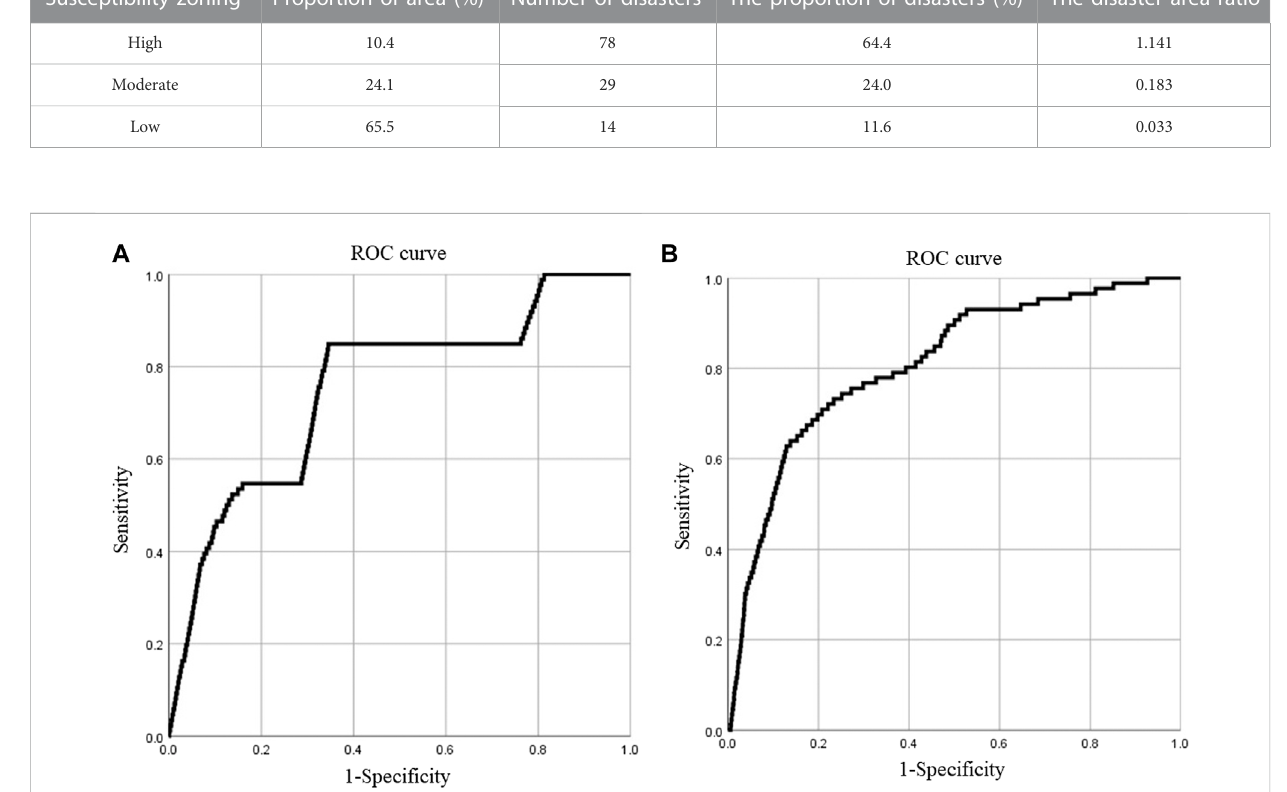
FIGURE 6 ROC curves of different evaluation model. (A) EWM-IV model; (B) EWM-Apriori-IV